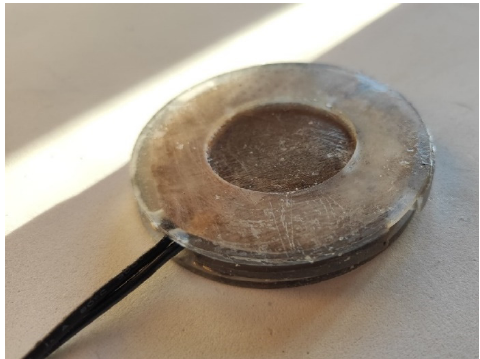
Figure 13. Finished view of the electrochemical cell.